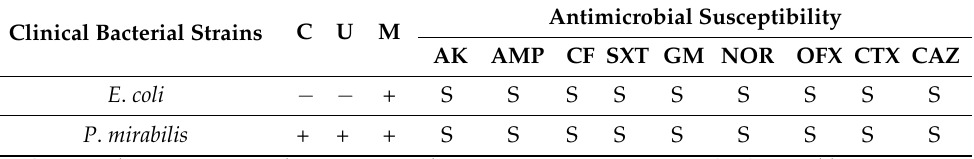
Table 1. The properties of E. coli and P. mirabilis isolates from the same stone matrix. Clinical Bacterial